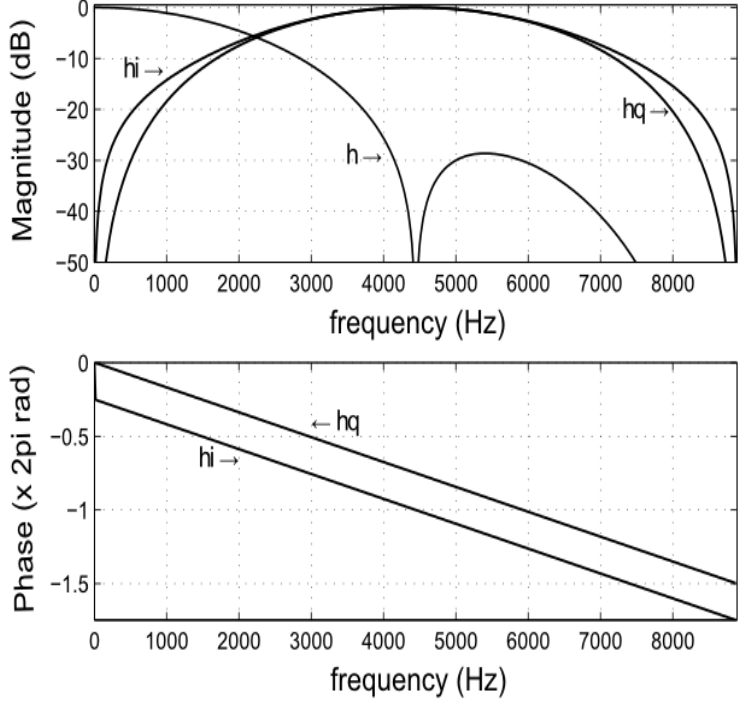
Figure 5. The normalized frequency response of the filters using a value of M = 5 = 17.78 kHz). (Above) Magnitude response of the low-pass prototype filter ( h ) and the ( F s band-pass in-phase ( h ) and quadrature ( h ) filters derived from it. (Below) Phase response i q of the band-pass in-phase and quadrature filters.